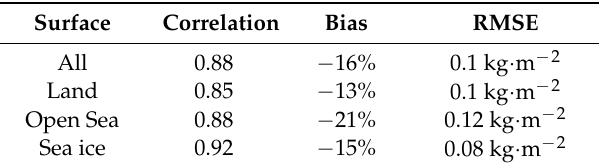
Table 1. Comparison of SWP observations from CPR, with SWP predictions for the complete evaluation dataset (All) over land, open sea and sea ice.